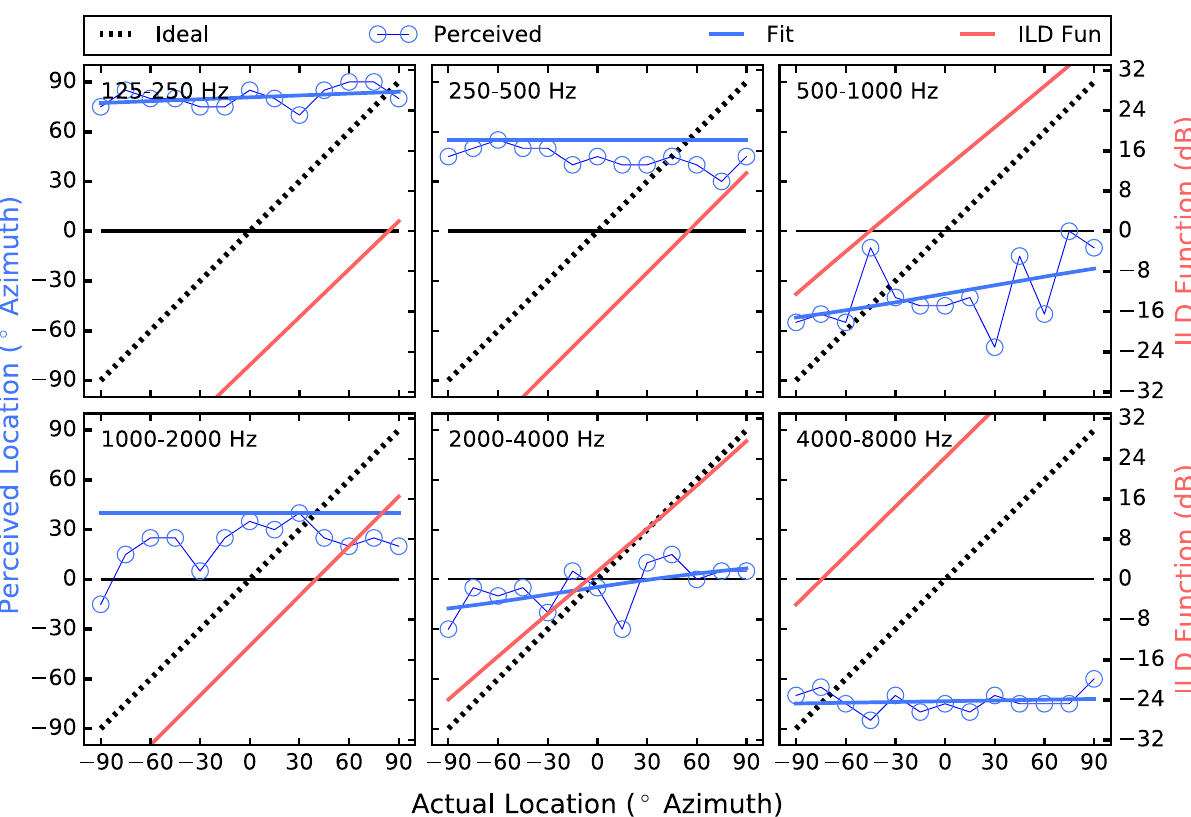
Fig 1. Corrective ILD generation data for participant 883. The six inset panels each represent a different frequency band, with cutoff frequencies indicated in the upper left corner of each inset panel. In each inset panel, the dashed black line represents ideal performance, the open blue circle markers depict perceived location plotted as a function of source location, and the heavy blue plot is a sigmoid fit to the localization data. The red functions are the corrective ILD functions for each band, which are the respective differences between ideal and the fit sigmoids, are expressed in dB, and use the y-axes to the